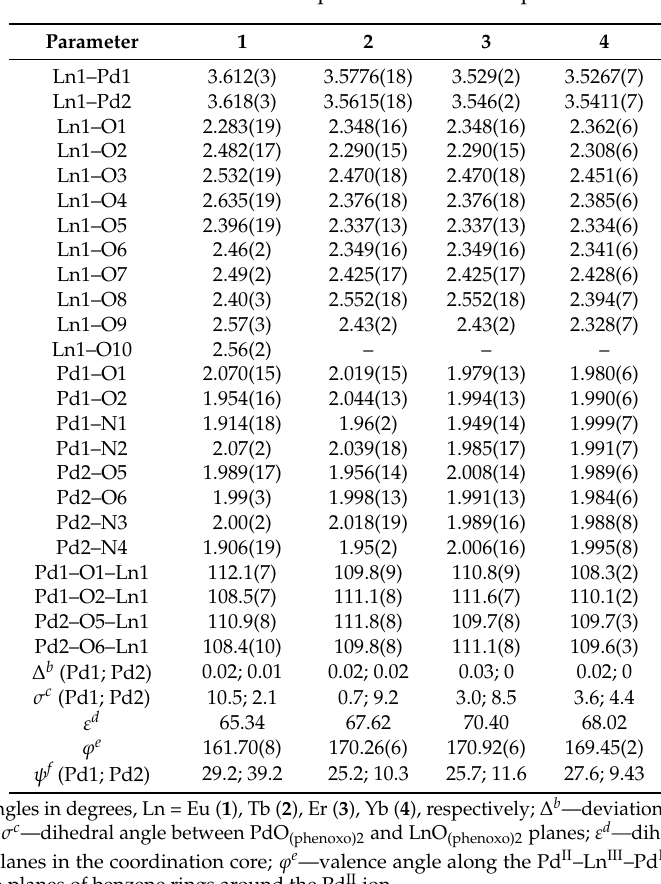
Table 1. Selected structural parameters a for complexes 1 – 4 .